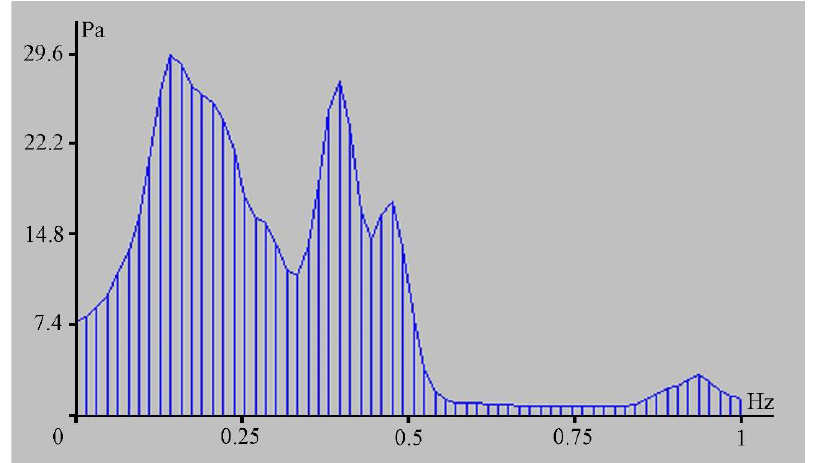
Figure 4. The spectrum of the recording of the supersensitive detector of hydrosphere pressure variations before the anomalous section.